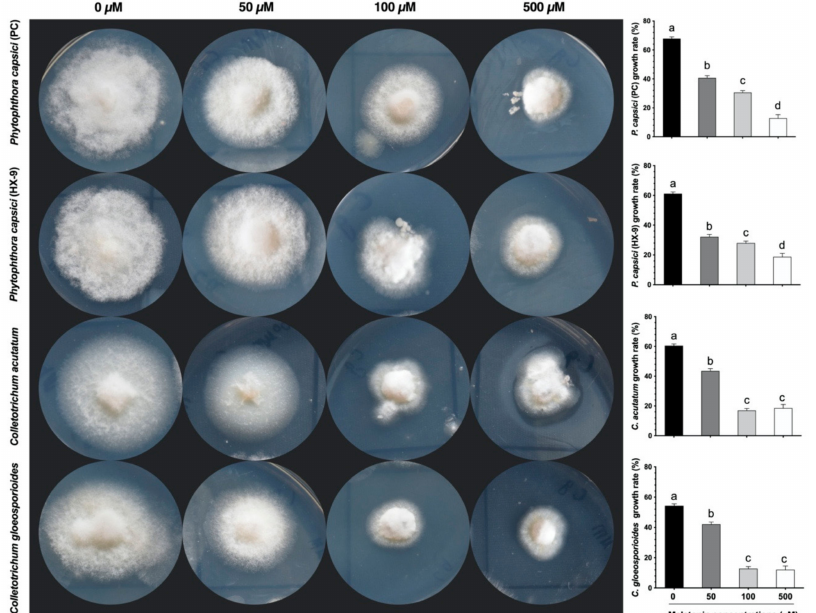
Figure 1. In-vitro apyrase inhibition effects of melatonin on the growth of different fungi and oomycetes. Representa- tive tphotographs of assay plates of Colletotrichum gloeosporioides , Colletotrichum acutatum , and two strains of Phytophthora capsici (PC and HX-9) in the presence of melatonin concentrations: 0, 50, 100, and 500- µ M, cultured on potato dextrose agar (PDA) medium. Here the mean values ± SDs of three replications are given. Lower case letters (a–d) on each histogram show differences at p ≤ 0.05 using the Duncan Multiple Range (DMR) test.